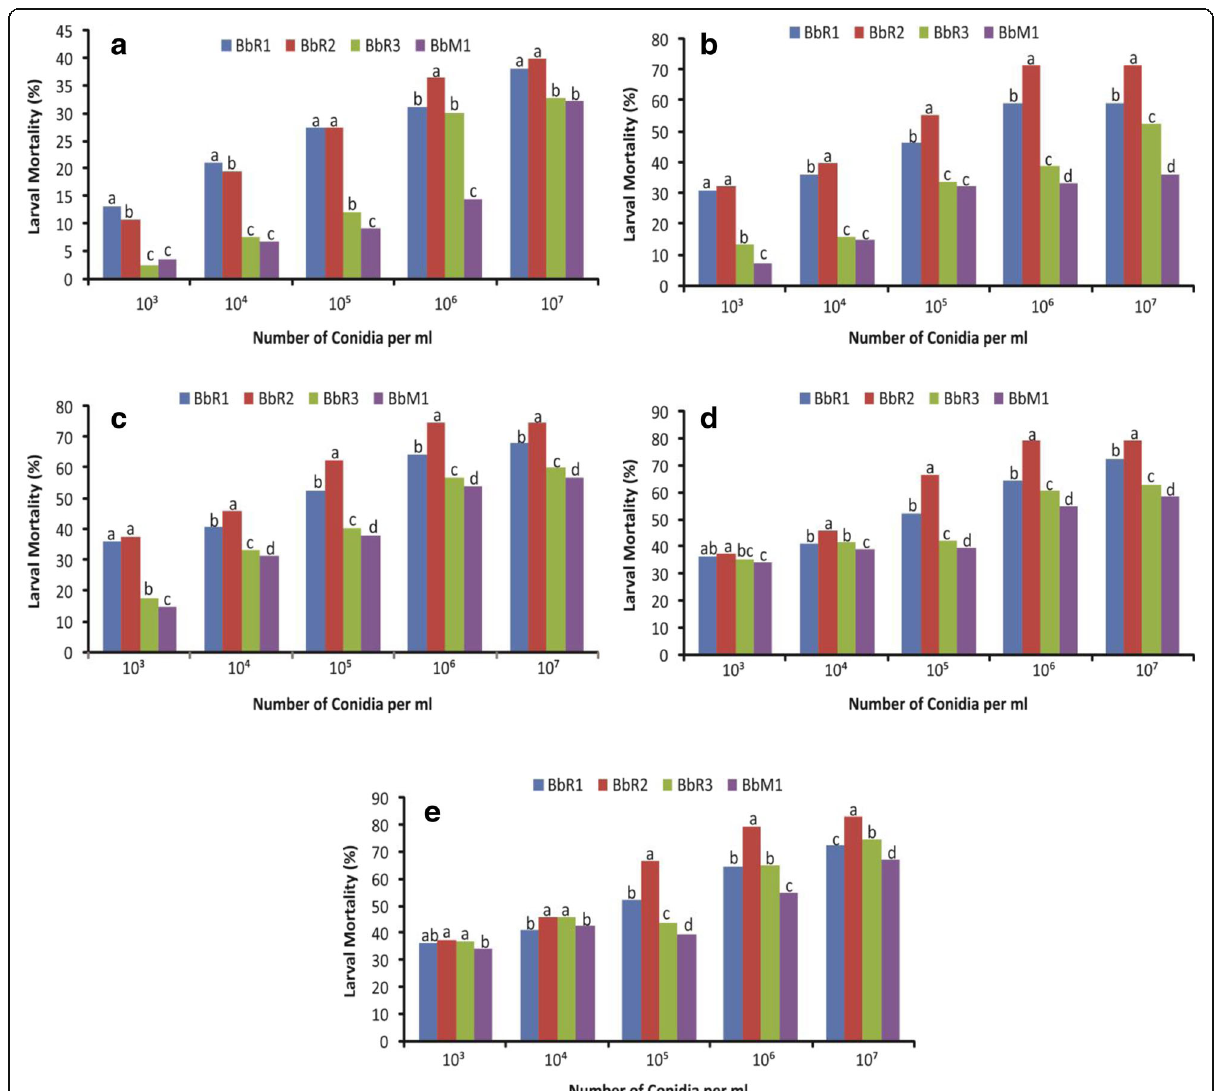
Fig. 6 Mortality of Spodoptera litura larvae by different Beauveria bassiana isolates after different intervals post infection. a 72 h. b 96 h. c 120 h. d 144 h. e 168 h. Different letters above the bars indicate values that are significantly different from each other ( P < 0.05)